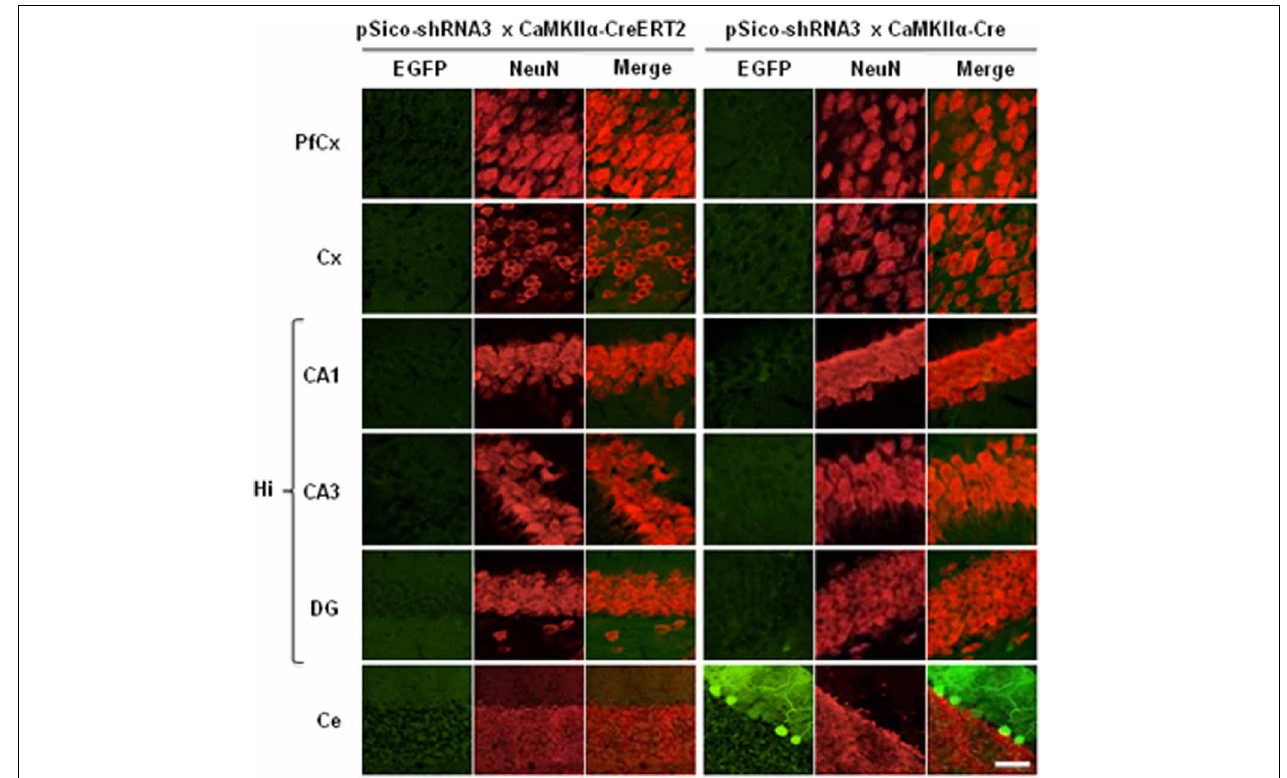
FIGURE 7 | Visualization of Cre-mediated recombination in neurons. EGFP (green) and NeuN (red) co-immunostaining in prefrontal cortex (PfCx), cortex (Cx), hippocampus (Hi: CA1, CA3, DG), and cerebellum (Ce). Sections from tamoxifen-treated pSico-shRNA3 × CaMKII α -CreERT2